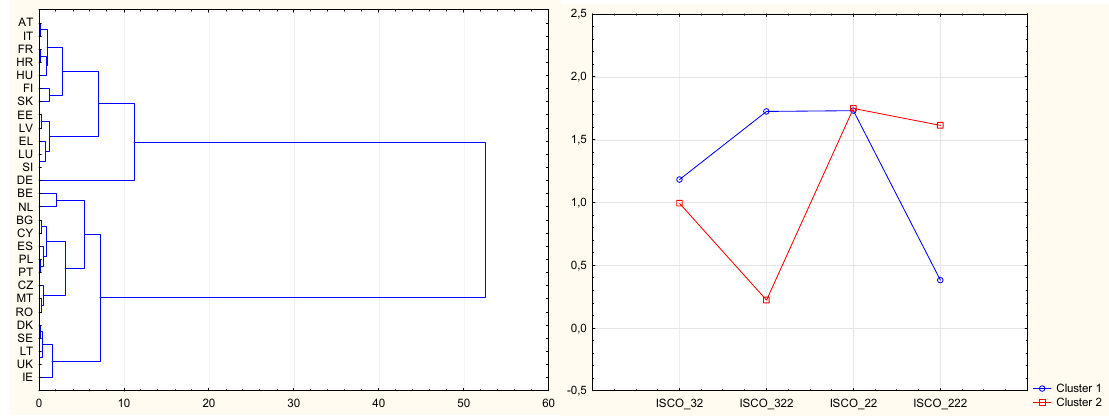
Figure 6. Dendrogram of hierarchical clustering ( left ) and the K-Means method ( right ).